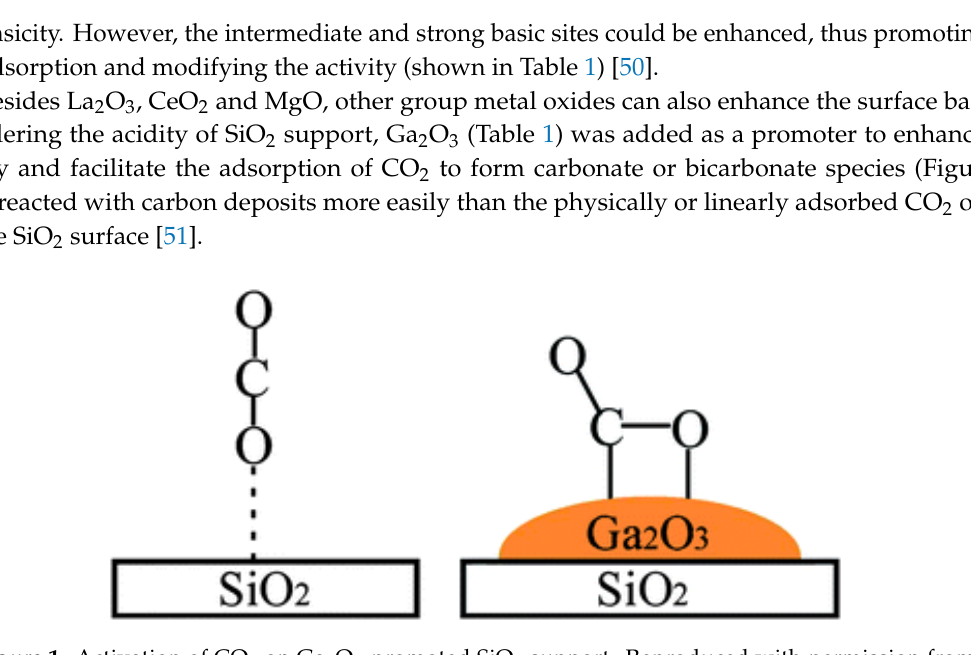
Figure 1. Activation of CO 2 on Ga 2 O 3 -promoted SiO 2 support. Reproduced with permission from reference [51].